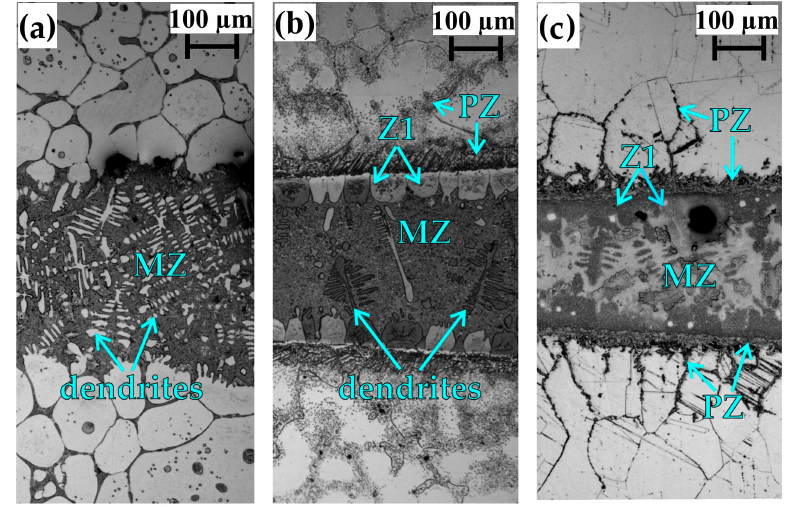
Figure 8. Micrographs of etched brazed materials: ( a ) Ni-Age-Was, ( b ) FSX-414, and ( c ) 304-SS. Etchant: 10 g CuCl, 40 mL HCl, 60 mL ethanol.